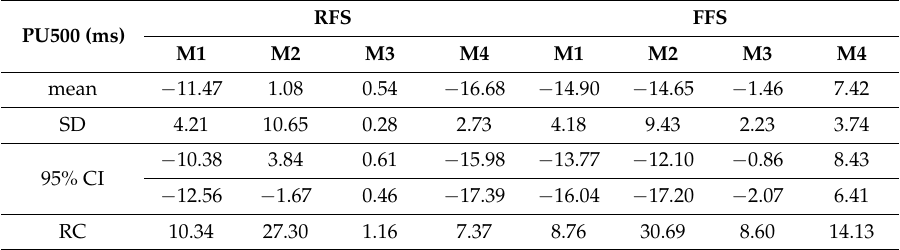
Table 3. Accuracy (mean) ± precision (standard deviation: SD), 95% confidence intervals (95% CI), and repeatability coefficient (RC) of foot strike detection methods (M1 to M4) for PUMA Speed 500 (PU500) and rearfoot (RFS) and forefoot strike (FFS) pattern.